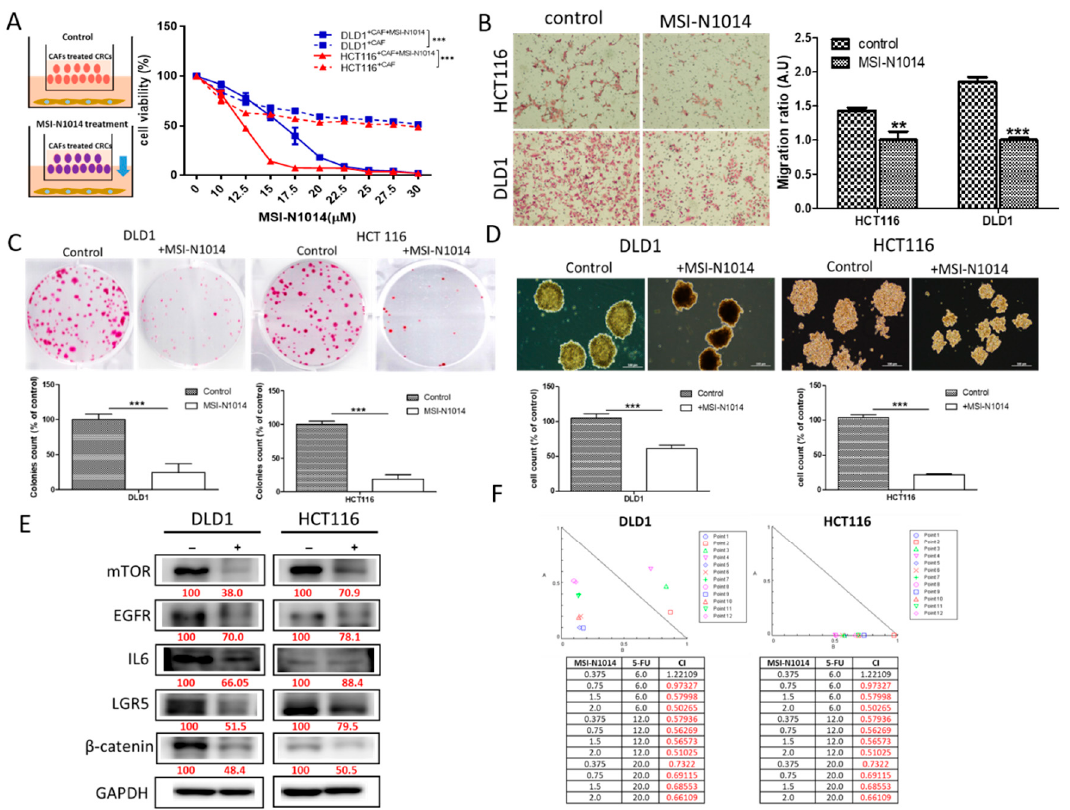
Figure 2. MSI-N1014 exerted anti-colorectal cancer (CRC) properties. ( A ) The insert depicts the experimental design where MSI-N1014 effect on cancer-associated fibroblast (CAF) CRC-cells were analyzed. MSI-N1014 dose-dependently reduced the cell viability of CAF-educated DLD1 and HCT116 cells. Reduced migratory ( B ), colony-forming ( C ), and tumor sphere-formation abilities ( D ) in both DLD1 and HCT116 cells post MSI-N1014 treatment. ( E ) Western blot analysis revealed reduced levels of mammalian target of rapamycin (mTOR), epidermal growth factor receptor (EGFR), interleukin (IL)-6, leucine-rich repeat-containing G-protein coupled receptor 5 (LGR5), and β -catenin in MSI-1014-treated cells compared to their control counterparts. ( F ) Isobologram analysis showing the synergistic effects of MSN-1014 and 5-fluorouracil (5-FU) were achieved in different concentration combinations in both DLD1 and HCT116 cells. Numbers in red indicate the relative expression ratio. ** p < 0.01, *** p < 0.001.